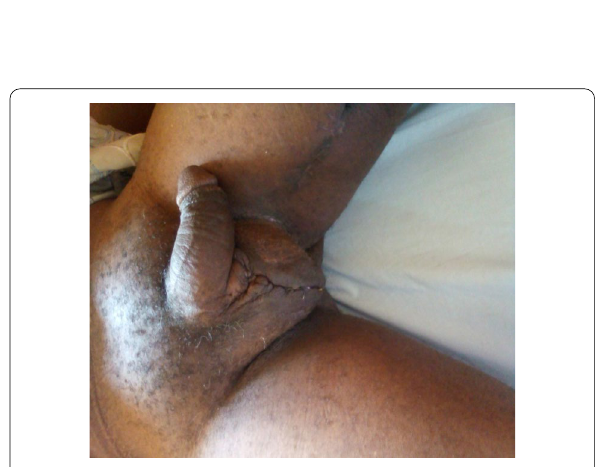
Fig. 9 The reconstructed scrotum at